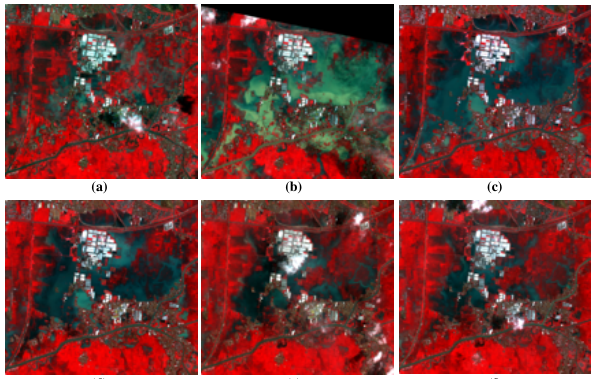
Figure 2. PLANET images covering Tegalluar area in east